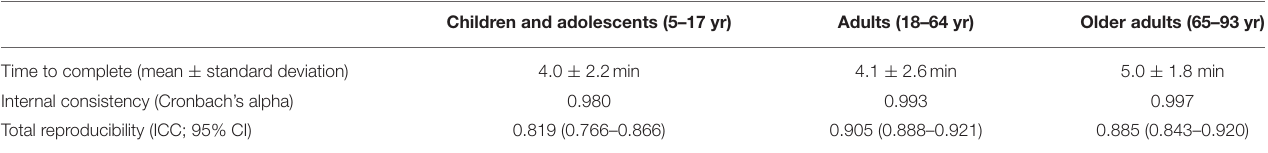
TABLE 2 | Time to complete the questionnaire, internal consistency, and total reproducibility according to each age group of individuals to validate the Brazilian Portuguese version of the PAR-Q +